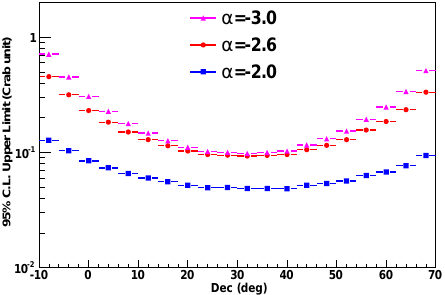
Figure 4: 95% C.L. flux upper limits for energy above 500 GeV, averaged over the right ascension, as a func- tion of the declination. The different curves indicate a different power-law spectral